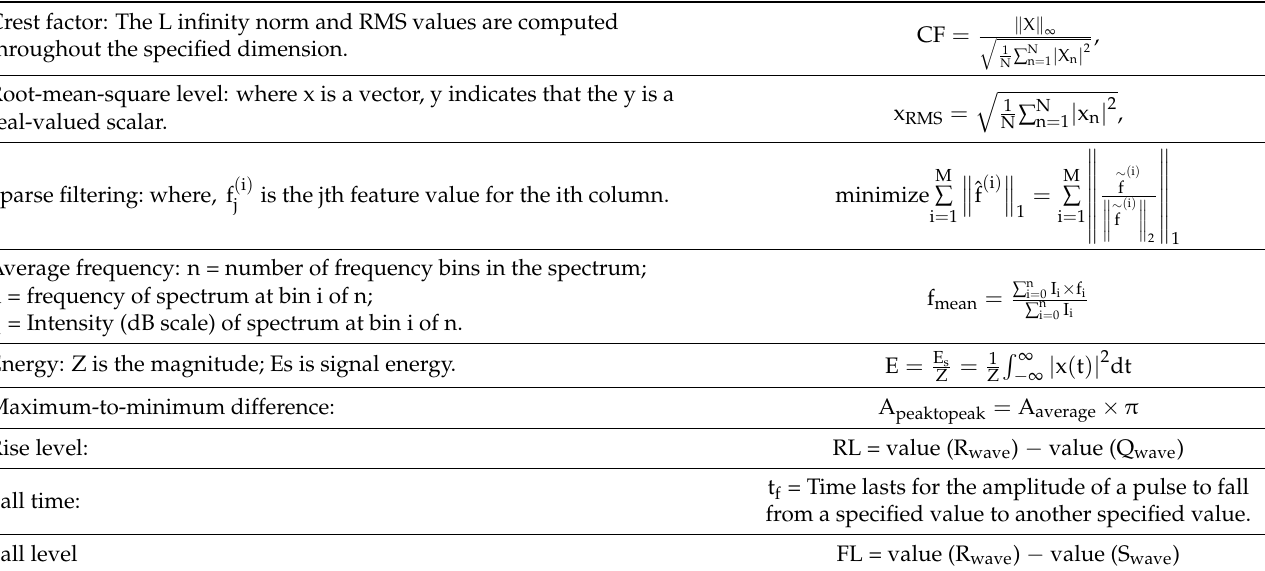
Table 5. Extracted features for signal